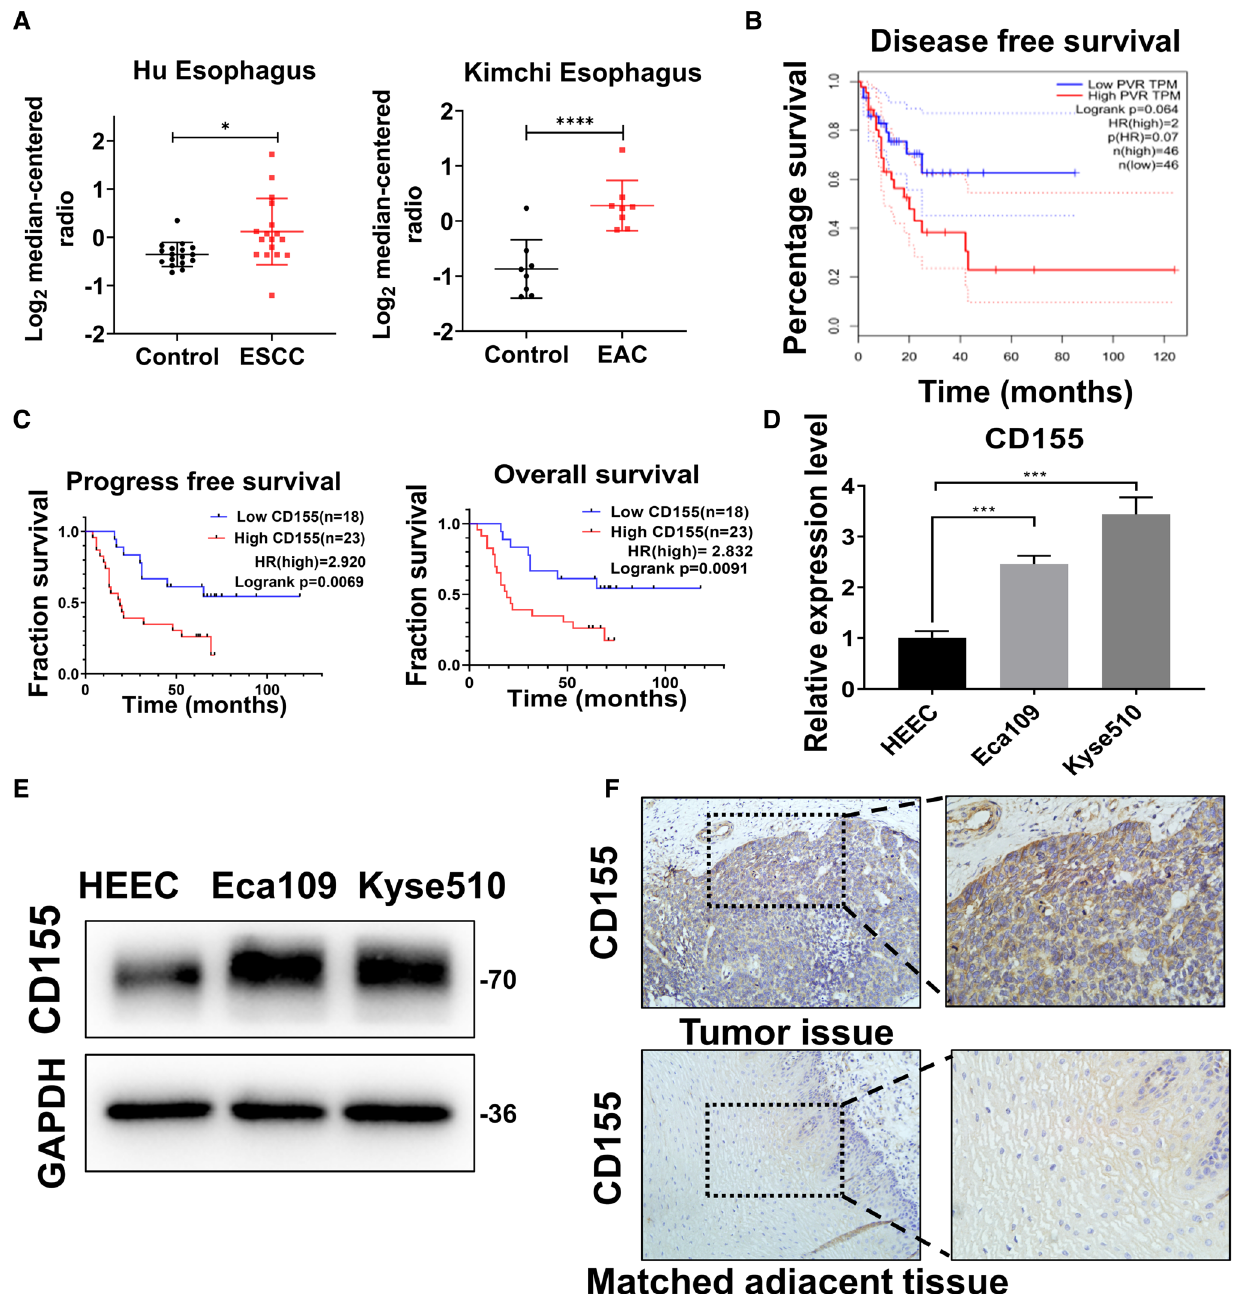
Fig. 1 CD155 overexpression is correlated with poor prognosis in EC. A Analysis of CD155 protein levels in esophageal squamous cell car- cinoma (ESCC) and esophageal adenocarcinoma (EAC) using gene expression data available in Oncomine. Expression levels of CD155 in normal (left plot) and cancer tissue (right plot) were plotted using GraphPad Prism software. The y-axis represents median ratio. B Progres- sion-free survival (PFS) analysis in patients with high and low CD155 expression levels. Image obtained from the cBioPortal. C Kaplan-Meier analysis of survival in patients with ESCC with low and high CD155 expression. D , E Analysis of CD155 expression levels in HEEC, Eca109 and Kyse510 cultured cells. D mRNA levels were analyzed using qRT-PCR. E Protein levels were measured using western blot F Immunohisto- chemistry (IHC) analysis of CD155 protein levels in ESCC tissues and adjacent normal tissues. Data are expressed as mean ± SD. * p < 0.05, ** p < 0.01 and *** p <